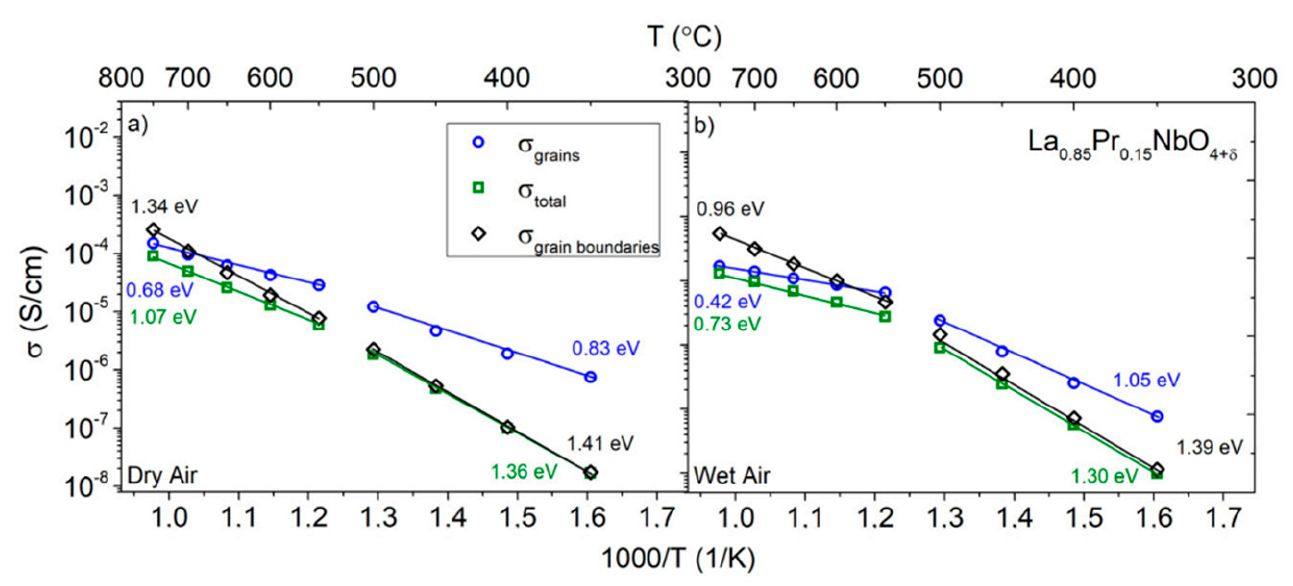
Figure 9. Total conductivity, grain conductivity and apparent grain boundary conductivity of La 0.85 Pr 0.15 NbO 4+ δ as a function of temperature measured in ( a ) dry (pH 2 O = 6.0 × 10 − 5 atm) and ( b ) wet (pH 2 O = 2.4 × 10 − 2 atm) air.